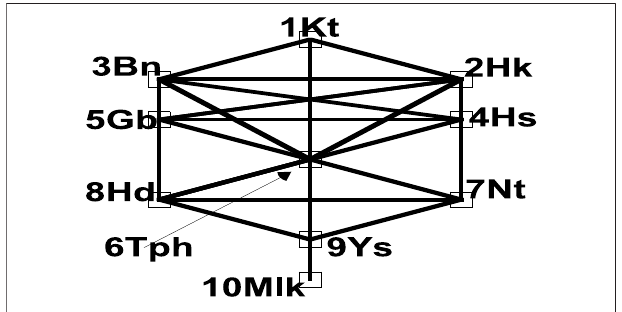
FIGURE 1 | The network of 10 sephiroths; notations of node labels are found in the main